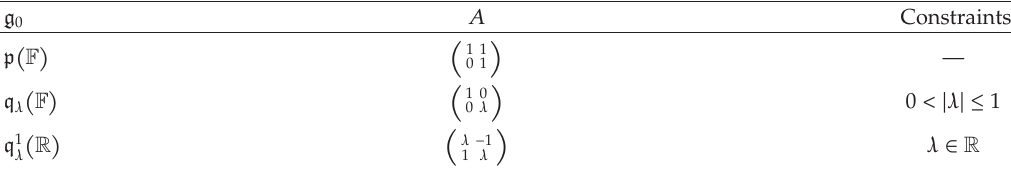
Table 1: Full set of representatives of the isomorphism classes of the 3-dimensional Lie algebras g have 2-dimensional derived ideal. The classes were obtained from the canonical form of the 2 × 2 invertible matrix A . In the first two cases, the field F can be either R or C